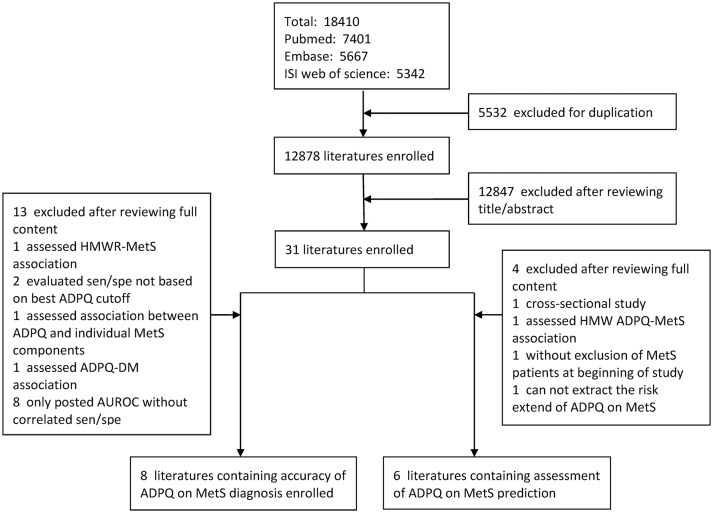
Flow diagram of selection for qualified studies in meta-analysis. AUROC, area under the receiver operating characteristic; DM, diabetes mellitus; HMW ADPQ, high-molecular weight adiponectin; MetS, metabolic syndrome; SEN, sensitivity; SPE, specificity.